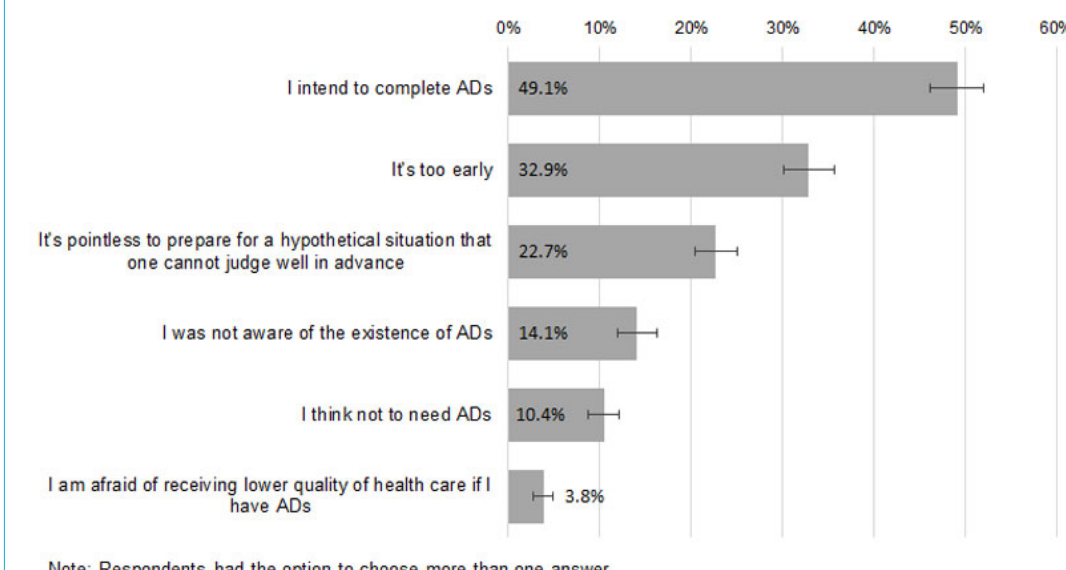
Figure 3: Reasons for not having completed an advance directive (AD), adults aged 55+ in Switzerland, weighted percentage and 95% confi- dence intervals, SHARE